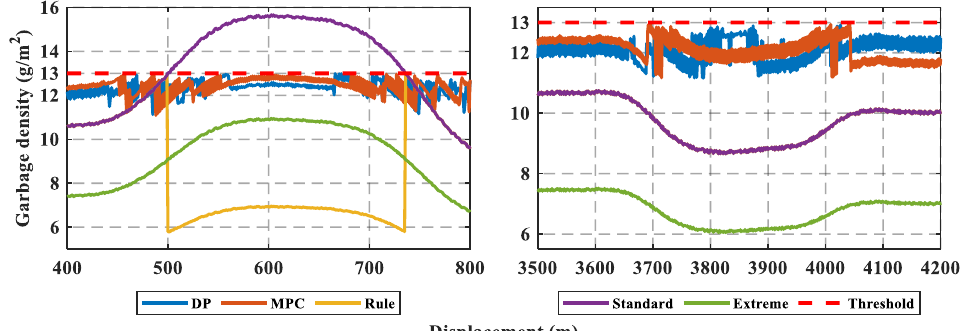
Figure 26. Magnified garbage residues.